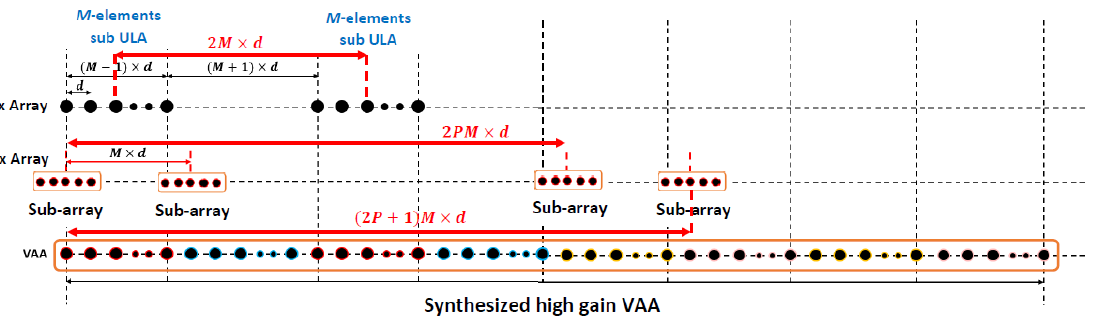
Figure 4. The synthesized high-gain VAA using four subarrays at the transmitting side.